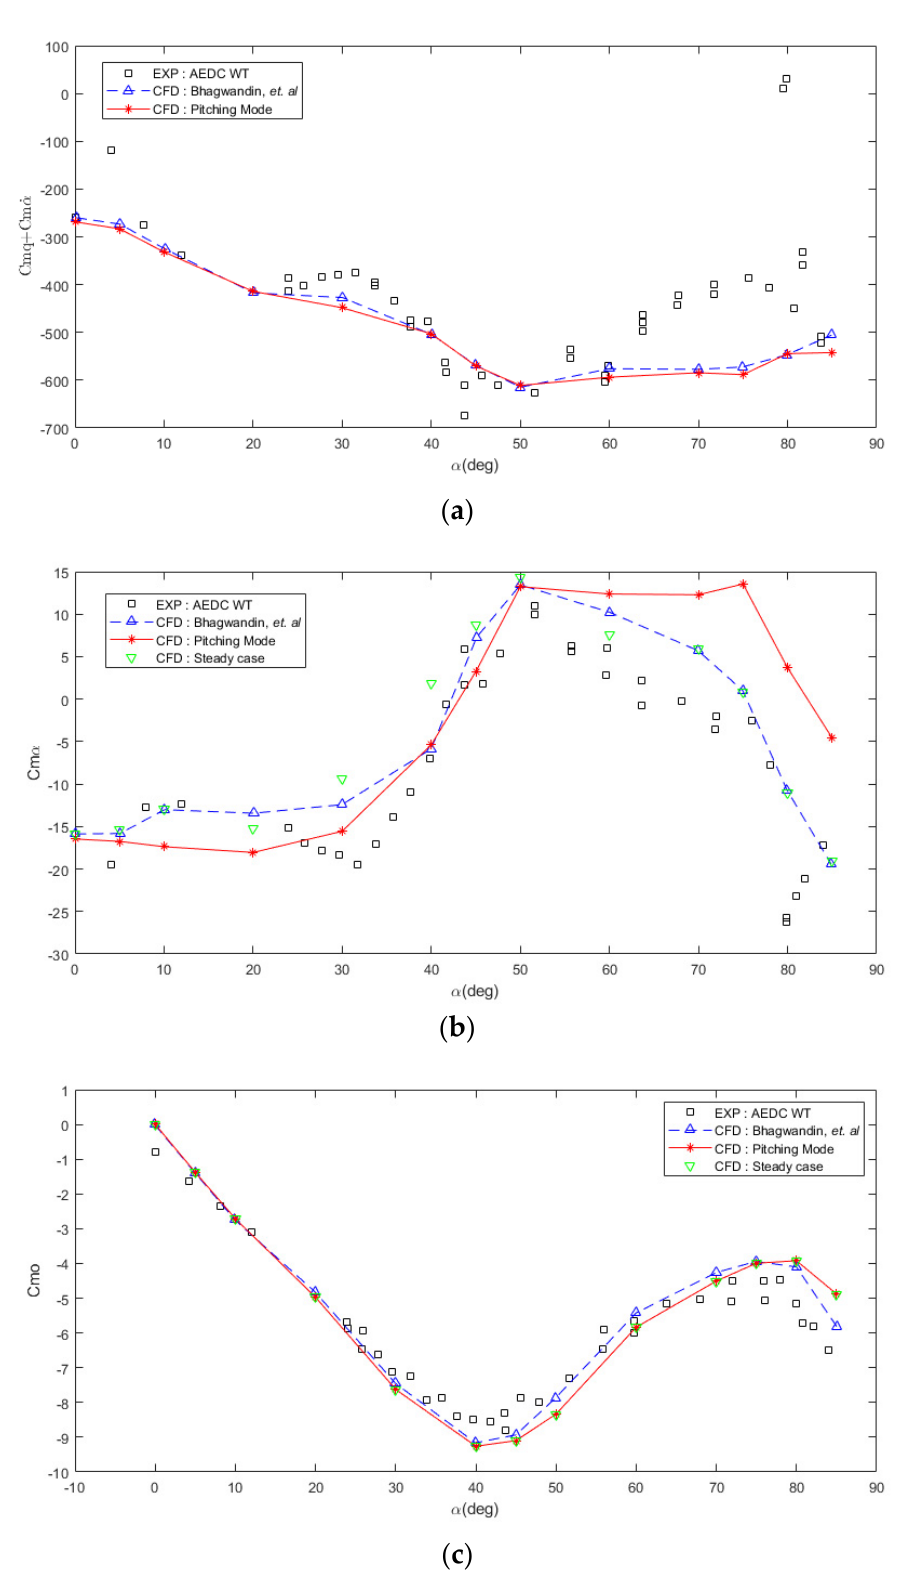
(cid:3397) (cid:3292)